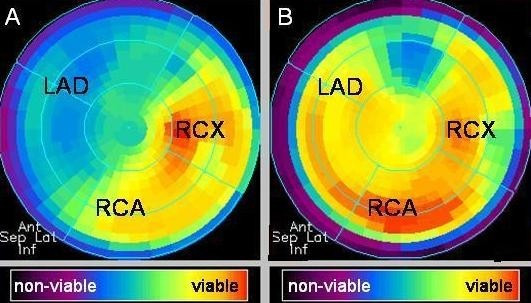
Corresponding polar map obtained from 18F-FDG-PET images of patient with myocardial infarction (see Fig. 4). Non-transmural defect at apex and anterior wall before surgical therapy (A). Increased viability in the region of the LAD 3 months after cell transplantation and CABG (B). LAD: left anterior descending coronary artery; RCA: right coronary artery; RCX: circumflex artery.